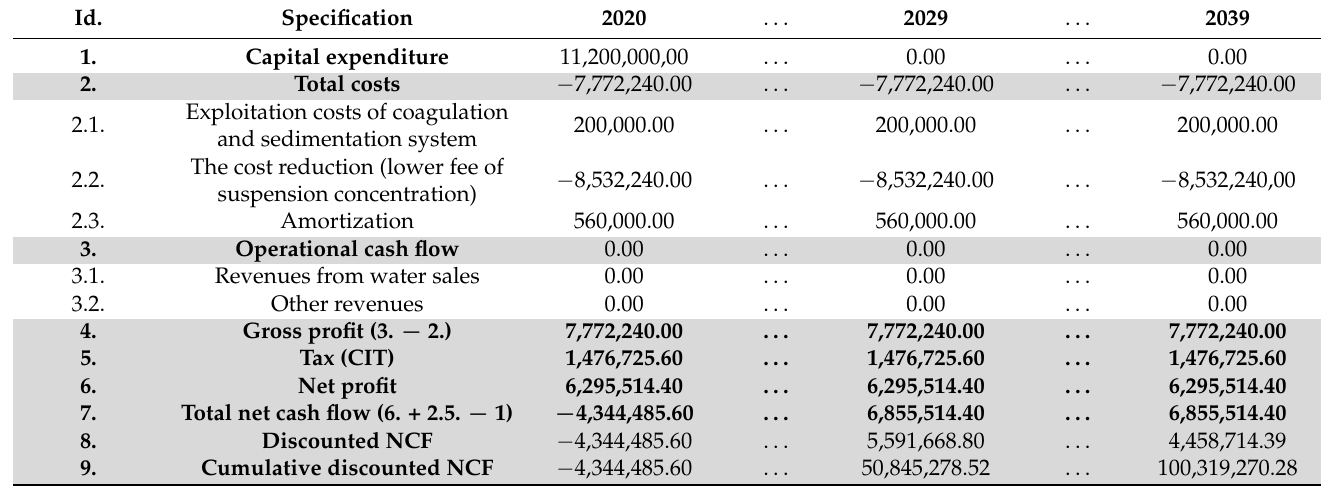
Table 2. Cash flows in Variant 1 (TSS concentration = 1000 mg/dm 3